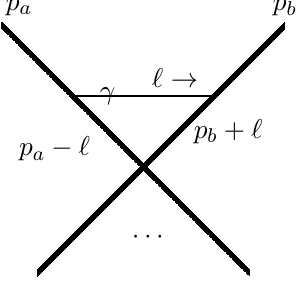
Figure 2 . One loop contribution to (cid:0) ( n; 1) involving internal photon line connecting two di(cid:11)erent points on the same leg. There are other diagrams related to this by permutations of the external scalar particles. In the last term the + on the scalar line represents a counterterm associated with mass renormalization that has to be adjusted to cancel the net contribution proportional to 1 = ( p a :k ) 2 .